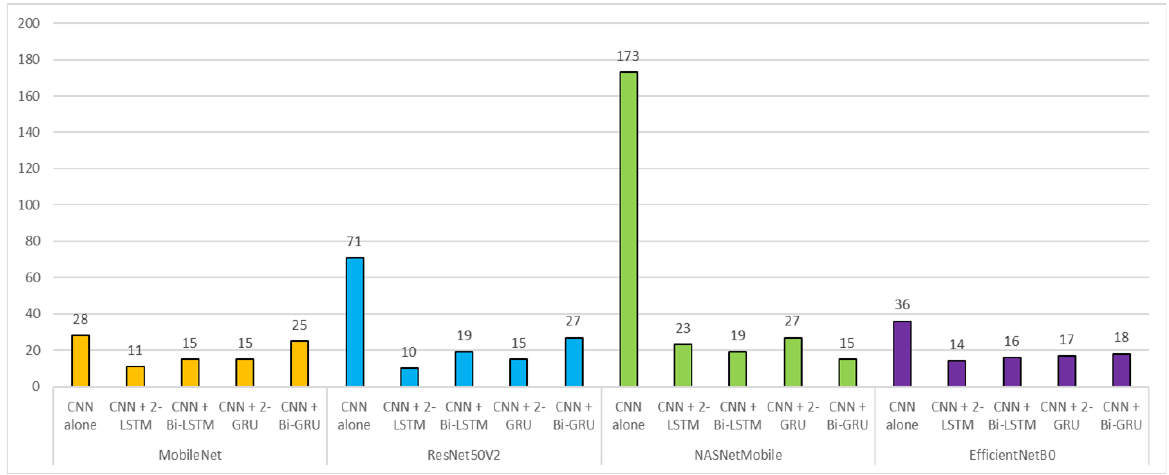
Figure 5. Comparison of SOTD values across deep learning models. SOTD was calculated to be the sum of the elements that are outside the tridiagonal entries. SOTD values were grouped by the type of the baseline deep CNN. The lower the SOTD value, the higher the prediction performance in general.